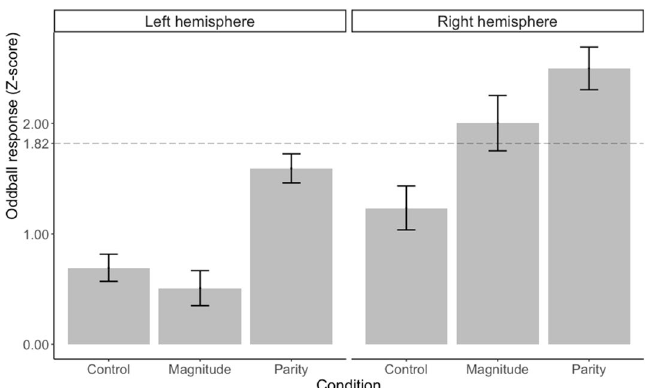
Figure 3. Mean amplitude, in Z-score, across the oddball frequency and its harmonics up to the seventh, as a function of the condition and as a function of the electrode lateralisation (left hemisphere: A9, A10, A11; right hemisphere: B6, B7, B8). Vertical bar depicts standard deviations. The horizontal dashed line represents the one- sided 95% threshold of significance ( Z > 1.82, p < .05,